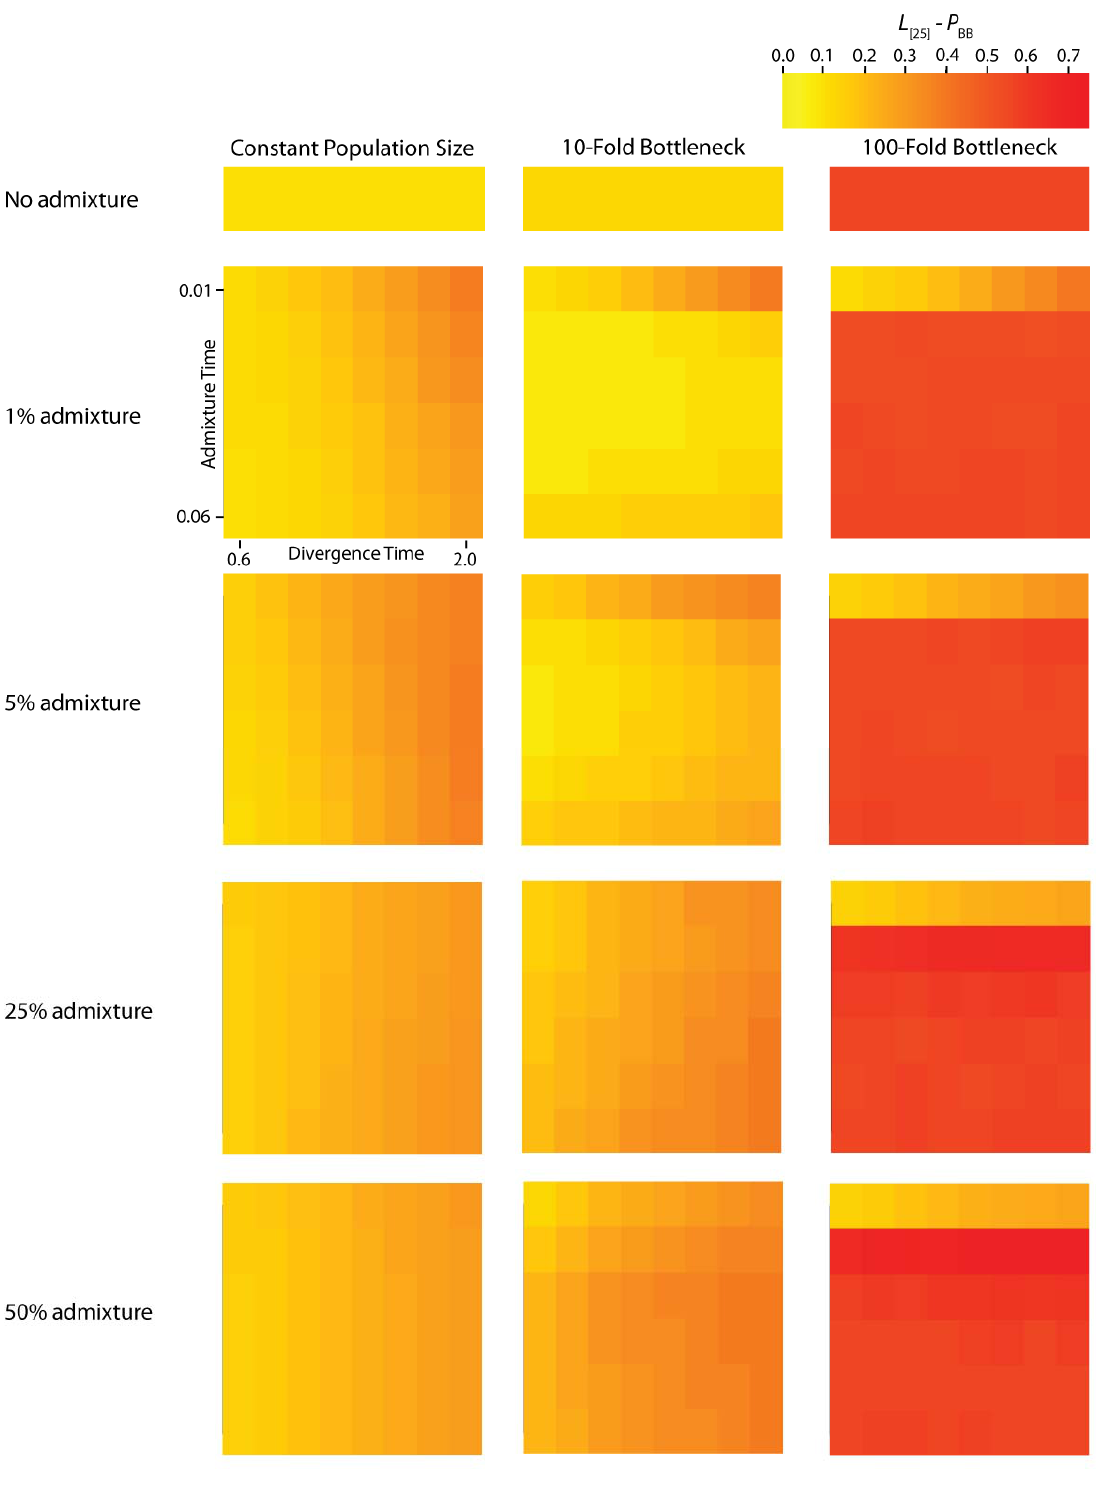
Figure 5. Simulated autocorrelation coefficients for P at a lag of 25 gene trees. Each BB column corresponds to a different magnitude of founder event in the colonizing population. Each row represents differing levels of admixture between the colonizing and endemic populations. Finally, within each panel, squares correspond to different combinations of population divergence time and admixture time in the IAA